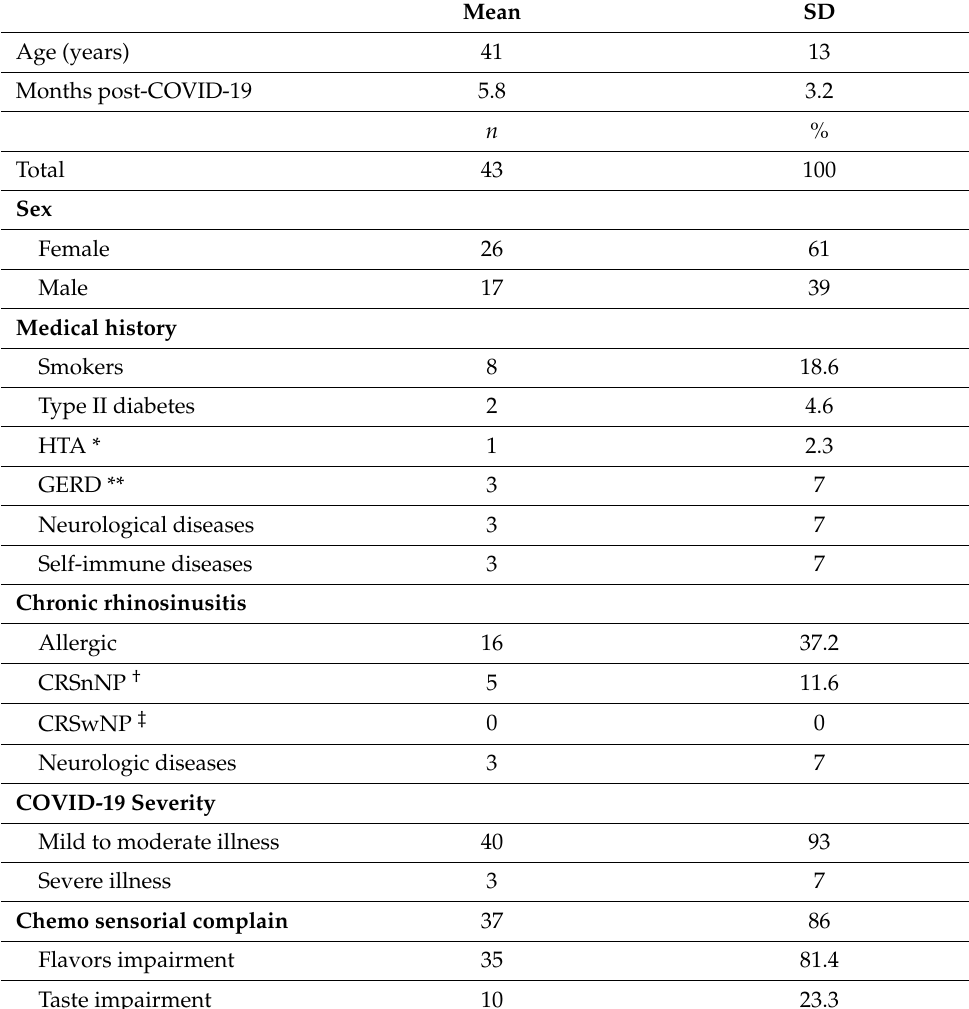
Table 1. Demographics and initial clinical patients feature. SD = standard deviation. * HTA = hyperten- sion; ** GERD = gastroesophageal reflux disease; † CRASnNP = chronic rhinosinusitis without nasal polyps; and ‡ CRASwNP = chronic rhinosinusitis with nasal polyps. Mean SD Age (years)